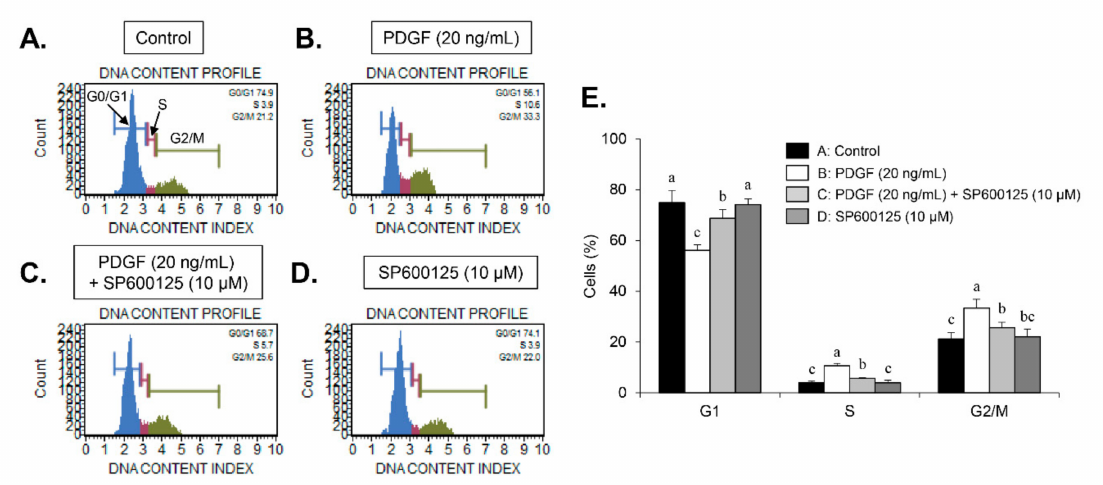
Figure 5. E ff ect of SP600125 in PDGF-induced reduction of VSMC population at G1-phase of the cell cycle. VSMCs were pre-incubated with SP600125 (10 µ M) for 45 min and then treated with PDGF (20 ng / mL) for 24 h. FACS histograms are shown for ( A ) control (Con), ( B ) PDGF alone, ( C ) 10 µ M SP600125 with PDGF, ( D ) 10 µ M SP600125, and ( E ) cell cycle profile is expressed as the percentages of cell population at the G1-, S-, and G2 / M-phases. Values are expressed as mean ± SD values of three independent experiments. The di ff erent letters indicate significant di ff erences between the groups ( p <